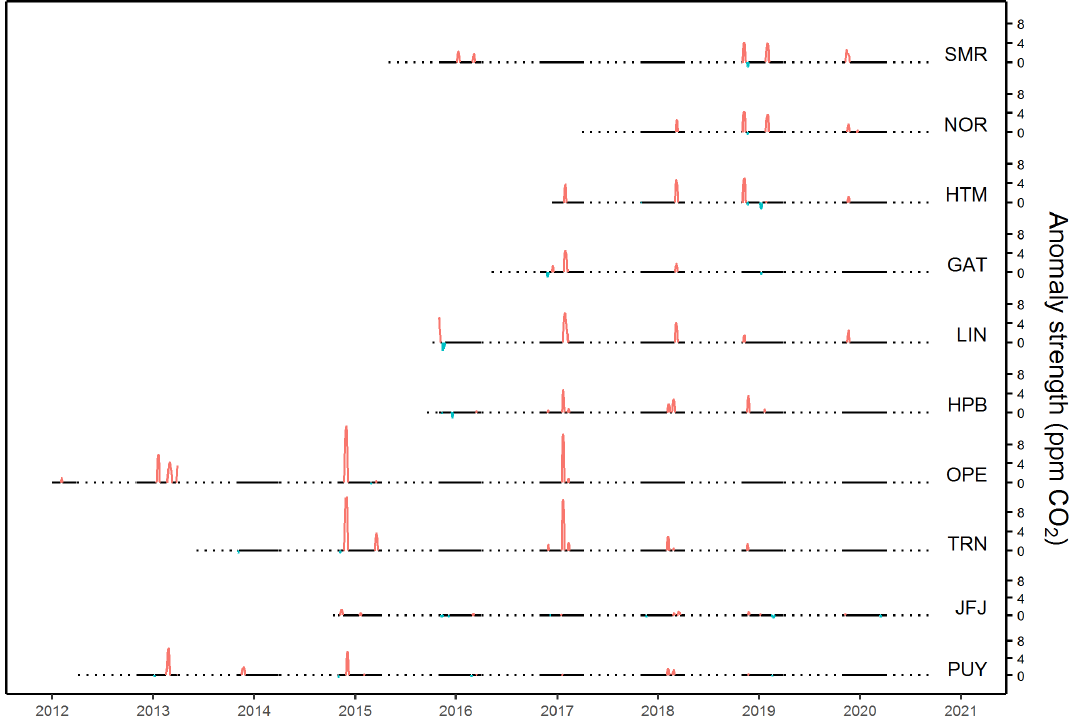
Figure 6. Positive (red) and negative (blue) SSAs in the complete CO 2 records of each site. The anomaly strength refers to the difference between the 30d LOESS curve and the boundary of the ± 2 σ 30 envelope.